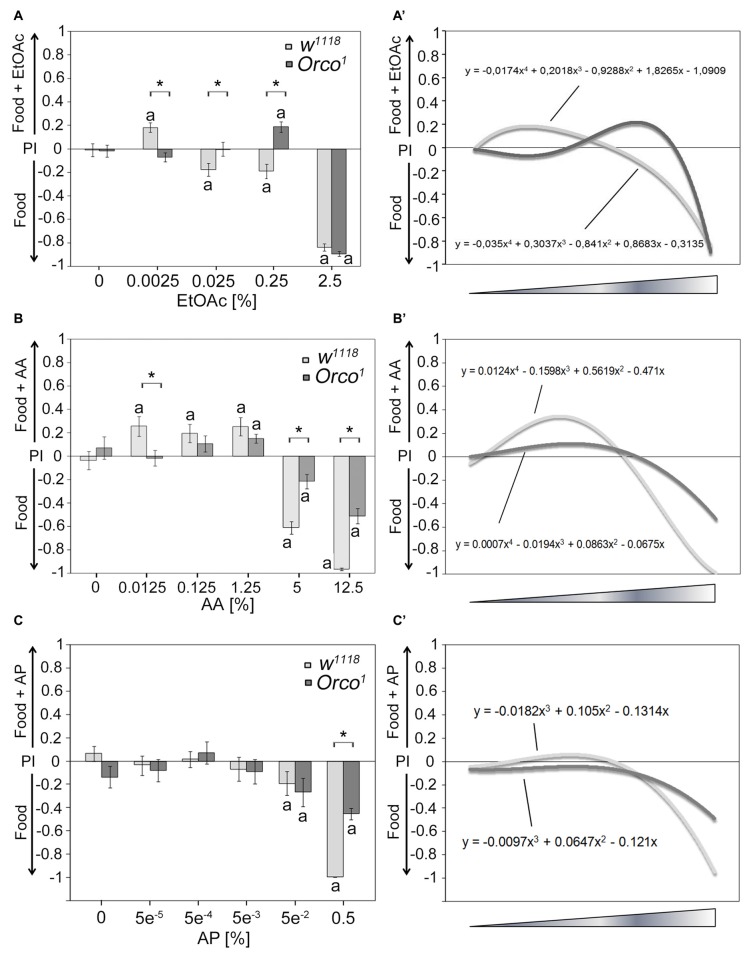
Dose-dependent attraction to ethyl acetate (EtOAc)-, acetic acid (AA)- and acetophenone (AP)-containing food odors. Dose-response curve for different (A) EtOAc, (B) AA and (C) AP concentrations in food odors compared to food odors for control flies and Orco1 mutants for EtOAc (N = 17–48; for AA: N = 13–22; for AP N = 16–27, respectively). (A′–C′) A polynomial analysis of the data presented in (A–C) of w1118 (light gray line) and Orco1 flies (dark gray line) reveals differences in the kinetics of odor attraction for (A′) EtOAc, (B′) AA and (C′) AP. The letter a marks differences from random choice as determined by a one-sample sign test (P < 0.05). The stars indicate significant differences as determined by Student’s t-test (P < 0.05).